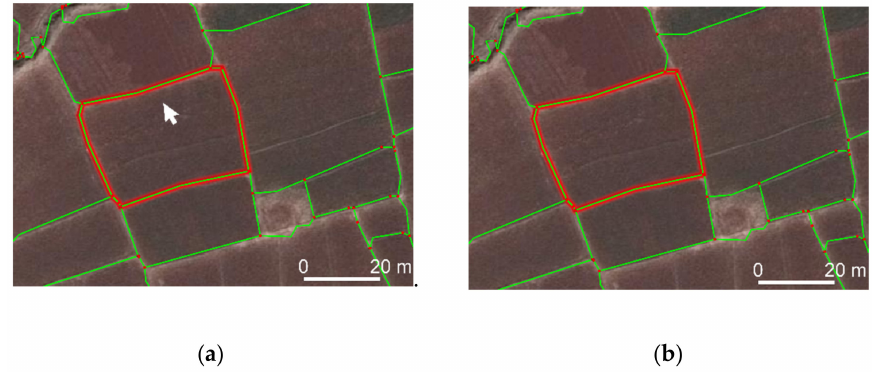
Figure 8. ( a ) Automated delineation requires clicking once somewhere in the parcel, while manual delineation requires precise clicking at least four times on each corner. ( b ) Boundaries partly covered or delineated by vegetation impede indirect surveying and limit the e ff ectiveness of our automated delineation compared to manual delineation.